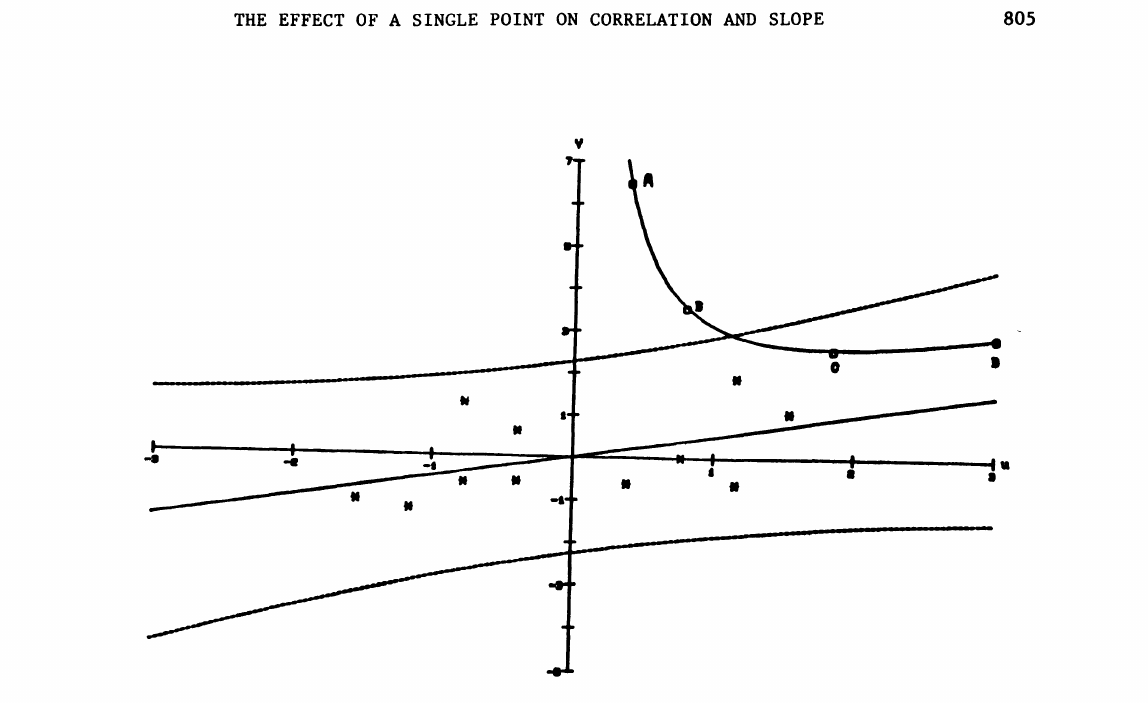
Figure 3: Numerical example described in Section